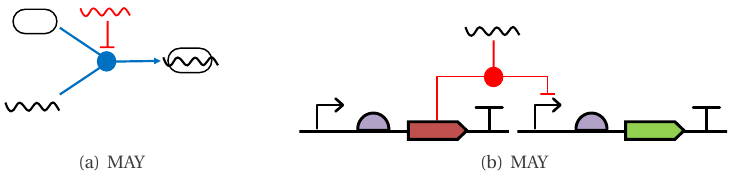
Figure 21: (a) Example of interaction node with an additional role indicated by an entering arrow head: association of gRNA and Cas9 inhibited by the presence of a competing gRNA. (b) Example of interaction node whose product plays